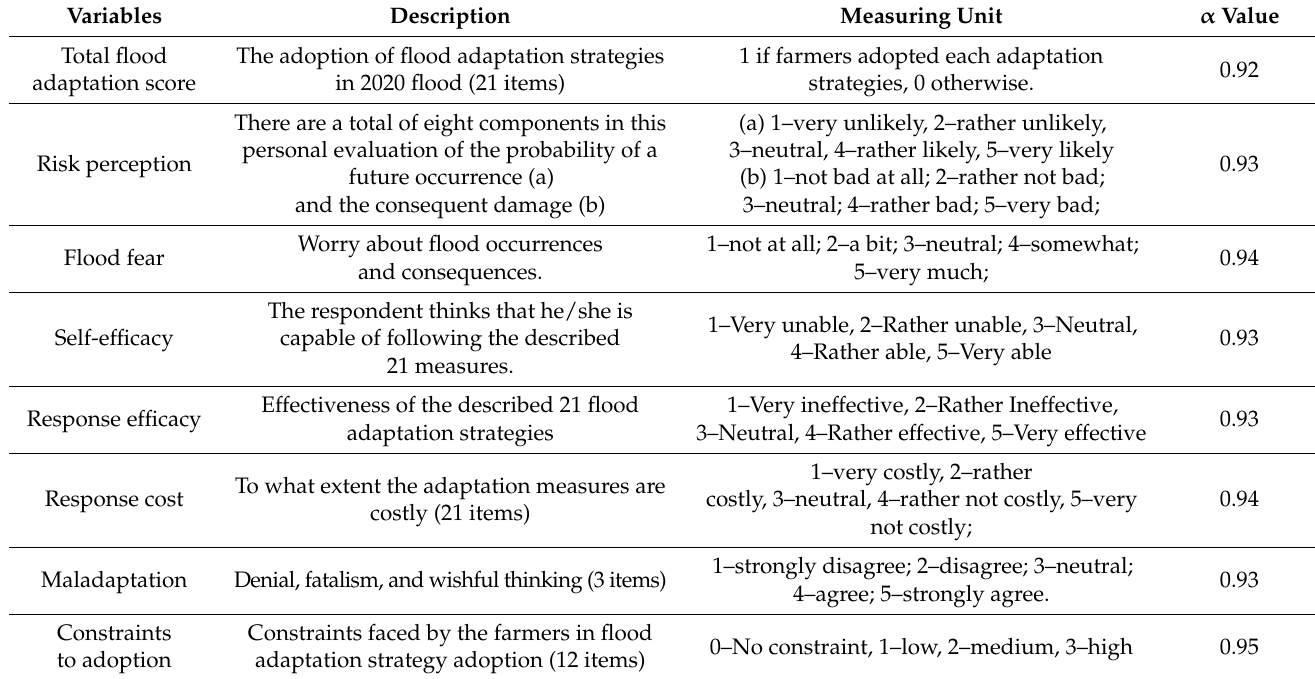
Table 1. Variables that are part of the protection motivation